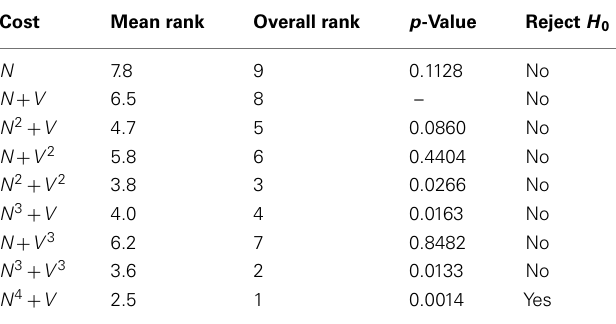
Table 6 |The mean quality ranking for each cost function based on x/y tracking alone, as well as the p -values obtained from statistical